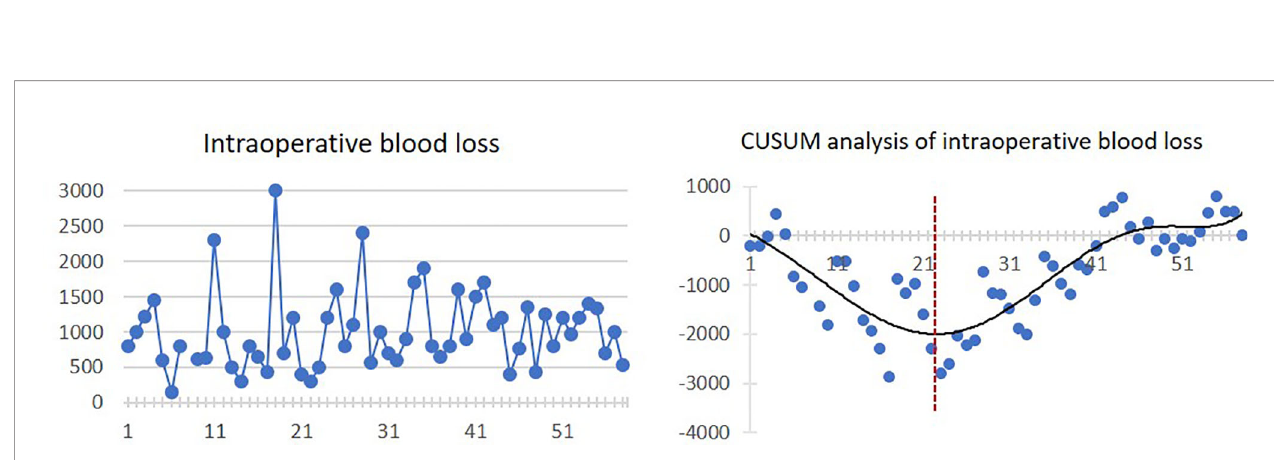
FIGURE 2 | Linear graph and CUSUM analysis of total operation time in CAJR applying patient-speci fi c surgical plates. The black line represents the curve of best fi t in a general model with equation, y = 4E − 06 x 6 − 0.0006 x 5 + 0.0299 x 4 − 0.3358 x 3 − 9.1732 x 2 + 168.85 x − 187.47, R ² = 0.8506.